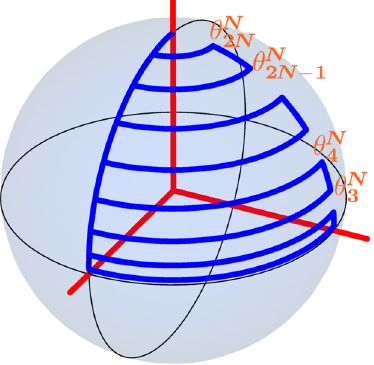
FIG. 6. The horizontal snake contour. A proper choice of the turning point θ N yields a solid angle of π = 4 with an exponentially n small error. Here, we show the contour based on Chebyshev x N ; n ¼ 1 ; … ; polynomials with N ¼ 4 and cos θ N , and x N n ¼ n n 2 N , are given in Eq. (15).